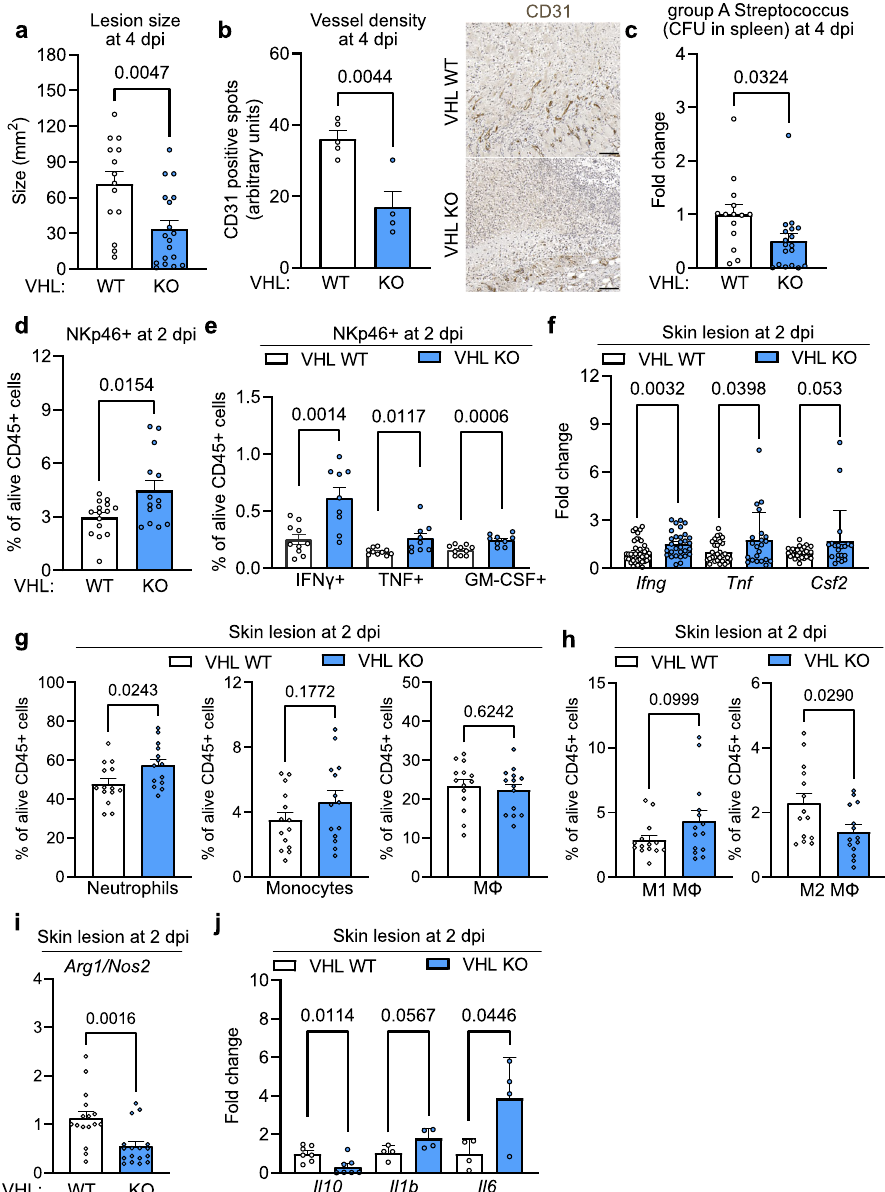
Fig. 6 Constitutive HIF-1 α expression in NK cells protects against bacterial skin infections. Analysis of GAS skin lesions from WT and VHL KO mice. a Quanti fi cation of independent skin lesion size area at 4 days post infection (dpi), pooled data of 4 experiments, ( n = 14 mice for WT, n = 18 for VHL KO). b Left, quanti fi cation of CD31 + endothelial cells at 4 dpi, pooled data of 2 experiments ( n = 5 for WT, n = 4 for VHL KO). Right, images of CD31 immunohistochemistry, scale bar, 100 μ m. c CFU of splenic GAS at 4 dpi, pooled data of 4 experiments ( n = 14 mice for WT and n = 18 for VHL KO). d FACS for NKp46 + cells in skin lesions at 2 dpi, pooled data of 4 experiments, ( n = 15 mice for WT, n = 14 for VHL KO). e FACS analysis of IFN γ -, TNF- and GM-CSF-expressing NKp46 + , NK1.1 + at 2 dpi, pooled data of 3 different experiments, ( n = 10 mice for WT, n = 9 for VHL KO). f Gene expression of Ifng, Tnf and Csf2 at 2 dpi, pooled data of 4 experiments ( Ifng , n = 40 mice for WT, n = 30 for VHL KO; Tnf n = 40 for WT, n = 22 for VHL KO; Csf2 , n = 30 for WT, n = 20 for VHL KO). g FACS analysis for neutrophils (CD11b + , Ly6G + ), monocytes (CD11b + , Ly6C + ) and macrophages (CD11b + , Ly6C + , F4/80 + ) at 2 dpi, pooled data of 4 experiments, ( n = 14mice). h FACS for M1 (CD80 + , MHCII + ) and M2 macrophages (CD206 + ) at 2 dpi, pooled data of 4 experiments ( n = 14 mice). i Expression ratio for Arg1 and Nos2 at 2 dpi, pooled data of 4 experiments, ( n = 16 mice for WT, n = 16 for VHL KO). j Gene expression of Il10, Il1b and Il6 at 2 dpi, pooled data of 3 experiments for Il10 and of 2 experiments for Il1b and, ( n = 7 mice for Il10 ; n = 4 for Il1b and Il6 ). Data are mean values ± SEM, statistical analysis: two-tailed Student ’ s t